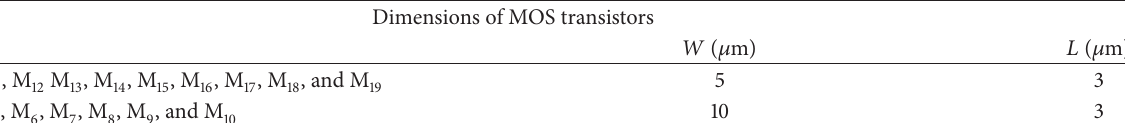
Figure 4: Internal structure of OTA [4]. Table 1: MOS dimensions [4].